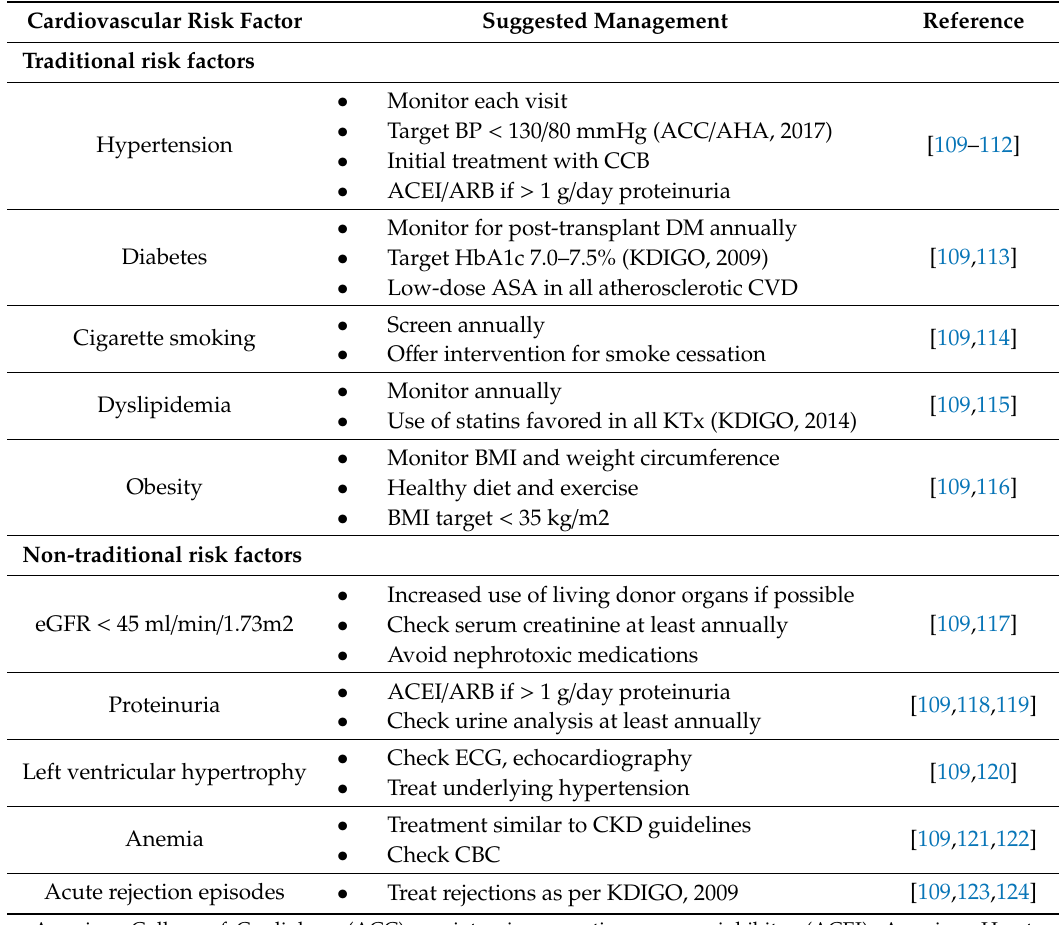
Table 1. Cardiovascular risk factors among kidney transplant recipients and suggested